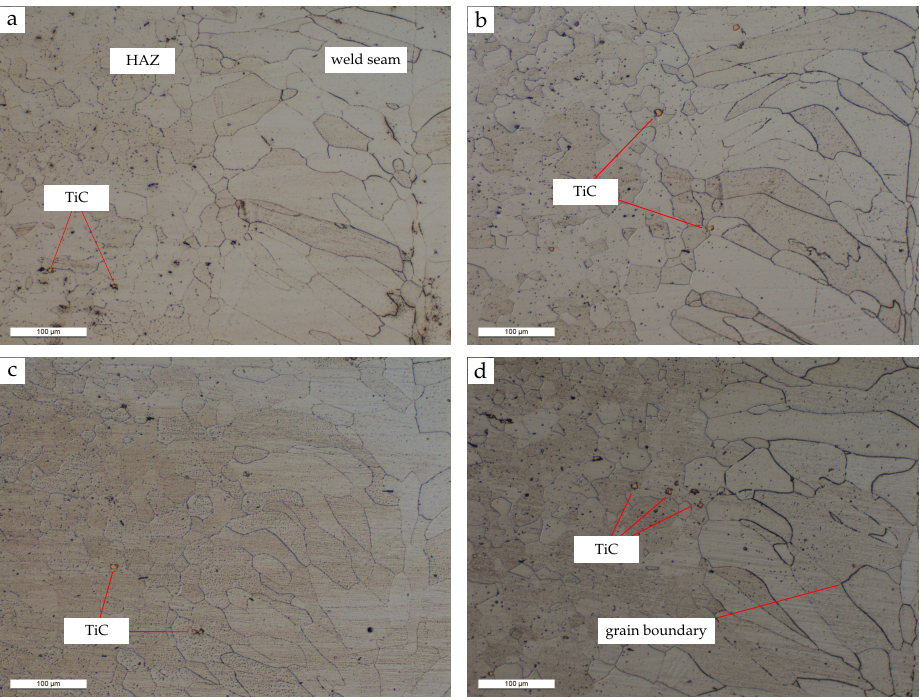
Figure 8. Etched micrographs of AISI430Ti weld seams and adjacent HAZ, obtained at energy inputs of ( a ) 18 J · mm − 1 , ( b ) 20 J · mm − 1 , ( c ) 22 J · mm − 1 and ( d ) 24 J · mm − 1 .